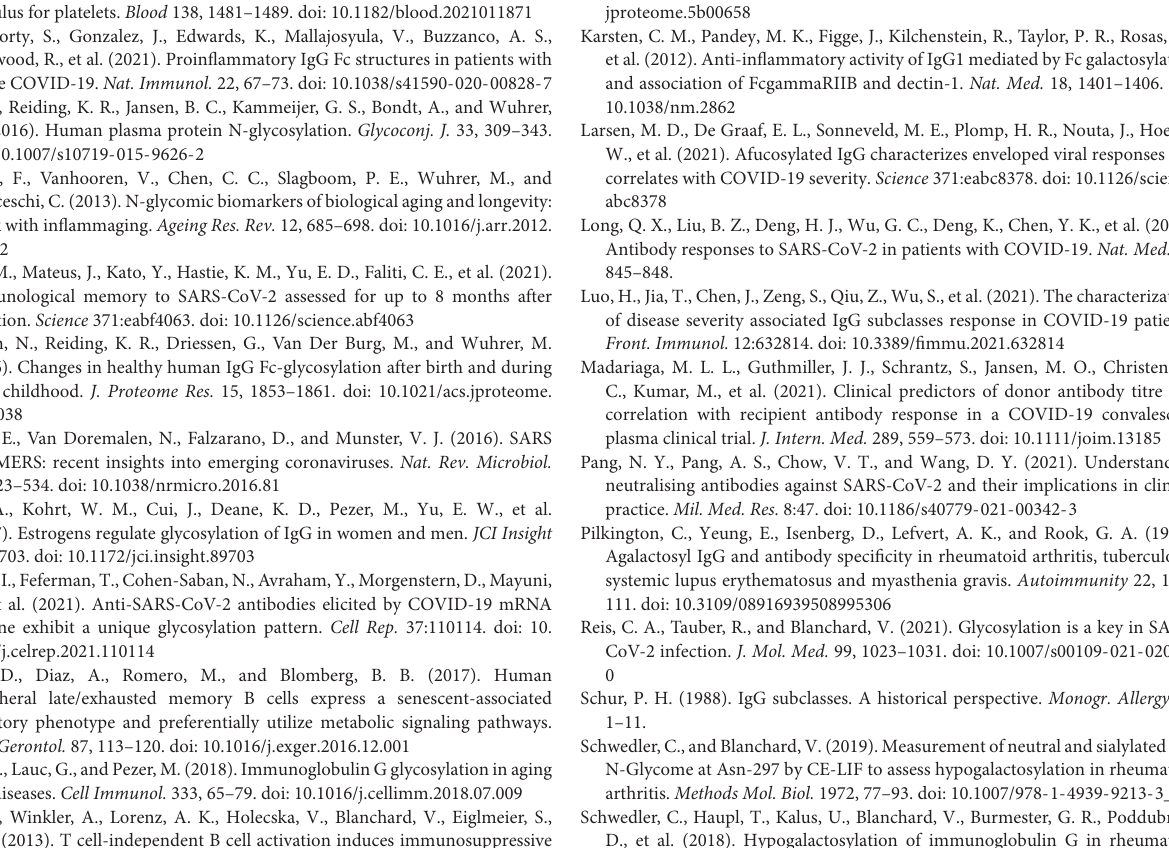
Supplementary Figure 1 | Inter-day repeatability testing of the analytical workflow used in this study. Average is shown as mean ± SD. Supplementary Figure 2 | Coronavirus disease 2019-related glycosylation alterations in patients with shorter ( < 20 days) and longer ( ≥ 20 days) hospitalization. (A) Total IgG 1 , (B) anti-S IgG 1 , and (C) total IgG 2 . The calculation of the glycosylation traits Gal, Bisec, Sial, and Fuc is given in section “MALDI-TOF Measurements and Data Analysis.” ∗ p < 0.05, ∗∗ p < 0.01. Supplementary Figure 3 | Longitudinal changes of (left) anti-S IgG 1 and (right) total IgG 1 Fc glycosylation in COVID-19 patients; (A,B) fucosylation, (C,D) galactosylation, (E,F) sialylation, and (G,H) bisecting GlcNAc. Data points corresponding to the two deceased COVID-19 patients are indicated in red (patient 1) and blue (patient 2).